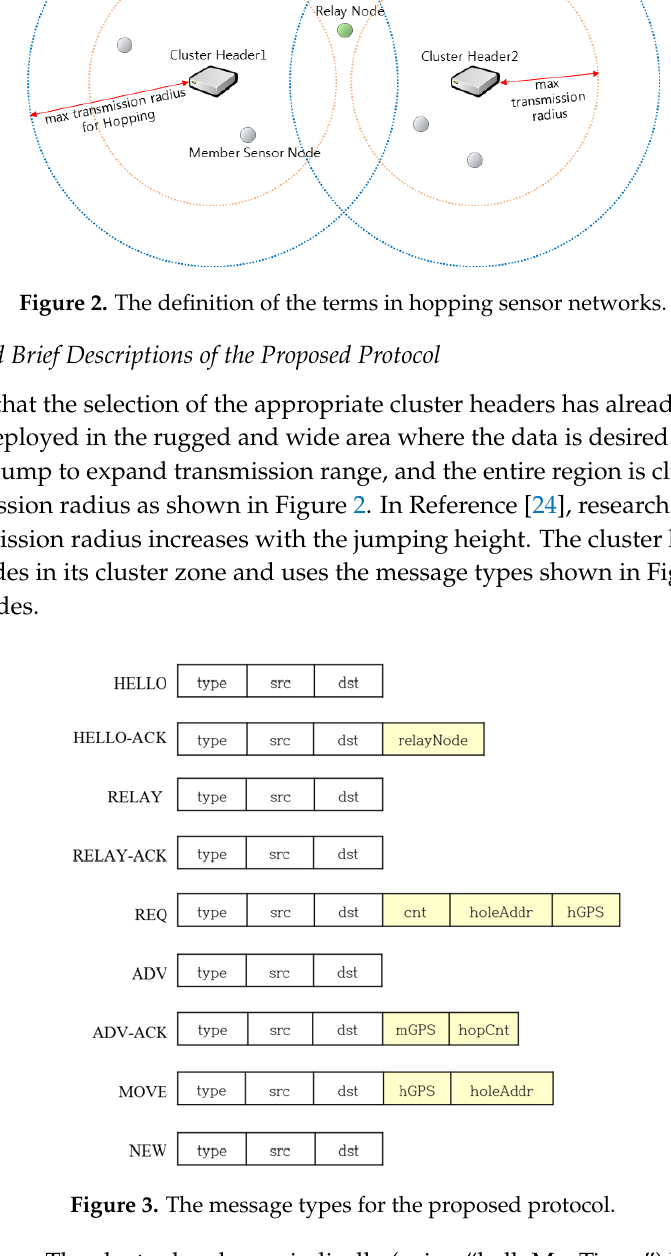
Figure 2. The definition of the terms in hopping sensor networks.